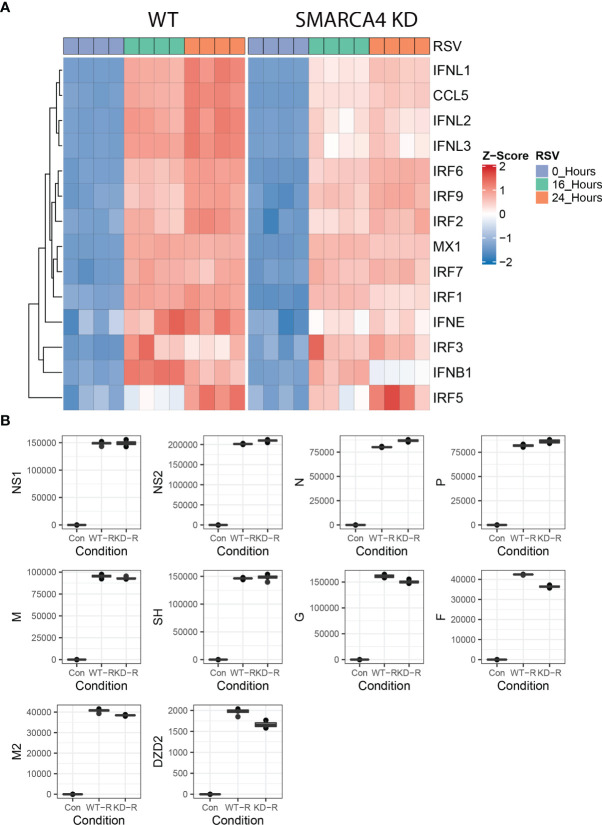
SMARCA4 complex depletion affects type III IFN response without affecting viral transcription. (A) Hierarchical cluster of type II and type III IFN genes in WT and SMARCA4 depleted cells. Genes are organized by row, treatment conditions by column. Color indicates row-wise Z-score. Dendrogram is Euclidian distance. (B) Quantitation of RSV transcripts. TPM values of short-read RNA seq are plotted by quartile (25%–75%) box plot. Horizontal line is mean value. For each transcript group comparisons are significantly different (2 way-Anova p<0.05) with virus infection vs mock-infected (con) contrast p<0.01 post-hoc Tukey’s. DZD2, RNA-dependent RNA polymerase; F, fusion protein; G, glycoprotein; M, matrix protein; N, nucleoprotein; NS, non-structural protein; P, phosphoprotein; SH, small hydrophobic protein.